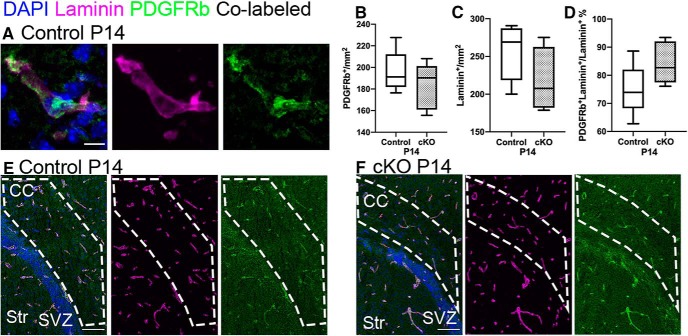
PDGFRβ+ cells and vasculature are normal in the Raldh2 cKO. A, PDGFRβ+ cells (green) co-localize with Laminin on blood vessels. B, Quantification of PDGFRβ+ structures. C, Quantification of Laminin+ structures. D, Percentage of Laminin+ structures co-localizing with PDGFRβ. E, F, Immunofluorescence for Laminin (magenta) and PDGFRβ (green), in the CC (area within the white dashed line) of control and cKO mice; co-localization shown in white. Mn, meninges; Ctx, cortex; CC, corpus callosum; SVZ, subventricular zone; LV, lateral ventricle; ChP, choroid plexus; Str, striatum; cKO, conditional knock-out. Scale bars: 50 μm (E, F) and 5 μm (A). Box and whiskers plot, box: 25th and 75th percentile, whiskers: minimum to maximum value, line at median.